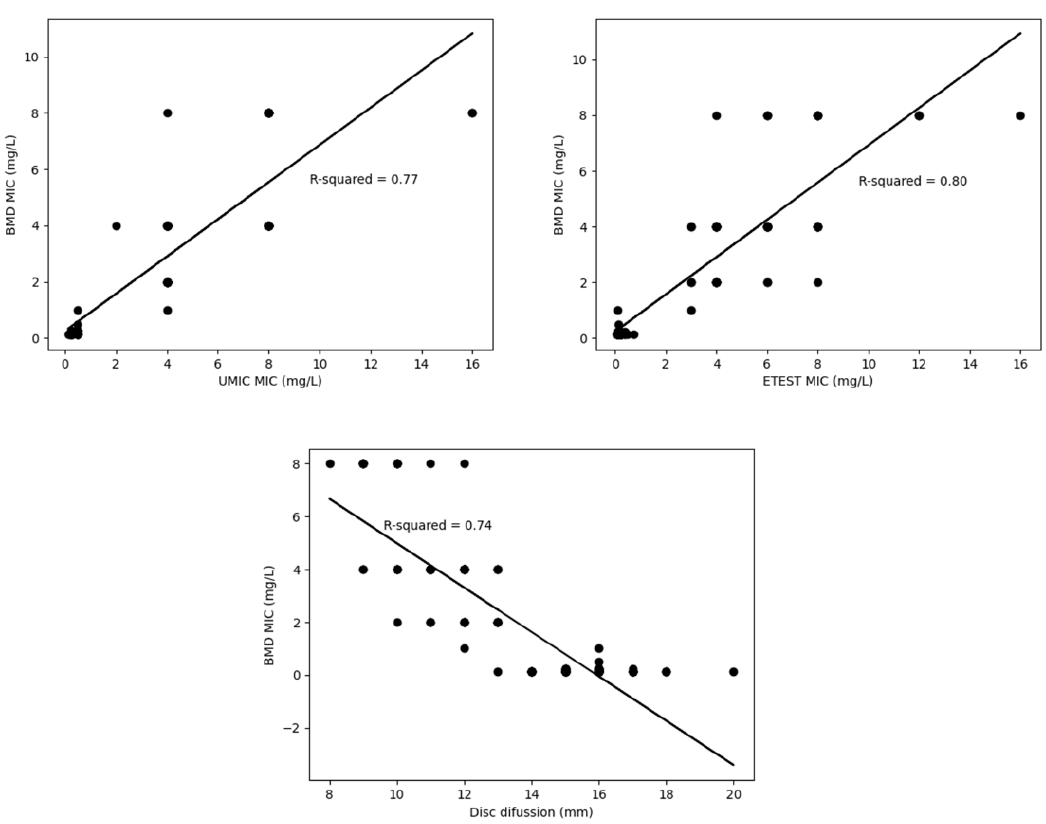
Figure 2. Correlation of each testing method versus the reference (BMD) represented by regression curves and R-squared.